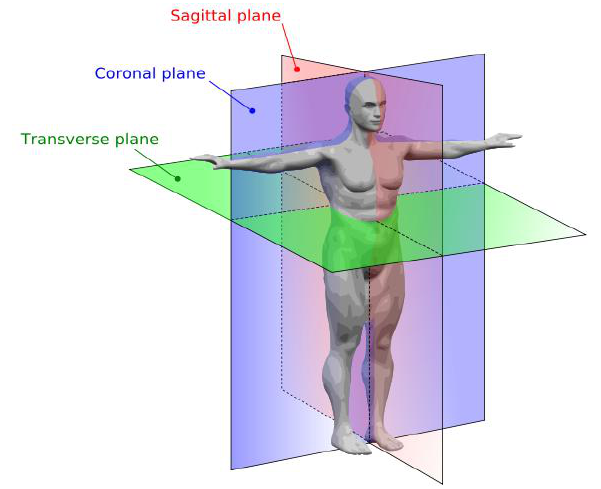
Figure 4. Diagram showing the three major planes of the body.